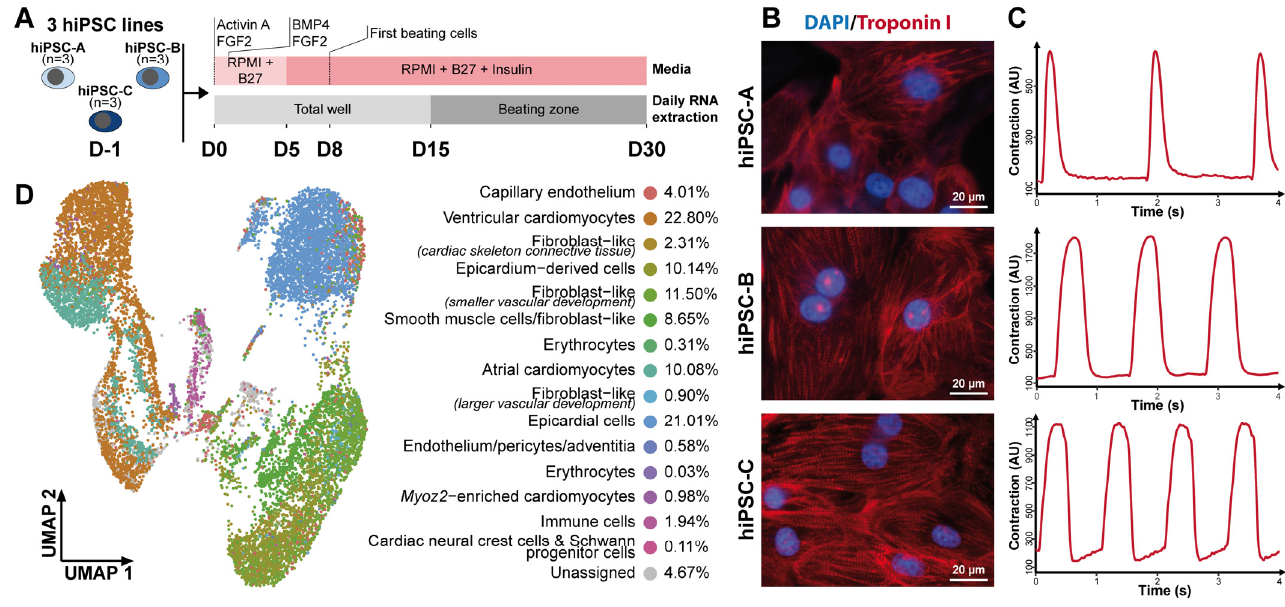
Figure 1. Transcriptomic and functional characterization of cardiac cells derived from hiPSCs. ( A ) Diagram illustrating the experimental design involving three distinct cardiac differentiations of three hiPSC lines reprogrammed from healthy donors. ( B ) Immunocytochemistry staining of troponin I (red) and DAPI (blue) at D30 of cardiac differentiation for all 3 hiPSC lines. ( C ) Representative contraction patterns captured by MUSCLEMOTION software on movies at D30 of cardiac differentiation for the 3 hiPSC lines. ( D ) UMAP displaying single-cell RNA-seq data at D30 of cardiac differentiation of hiPSC-A line. The color code indicates the different cell types identified. Cell population fractions are listed on the right. See also Figure S1.